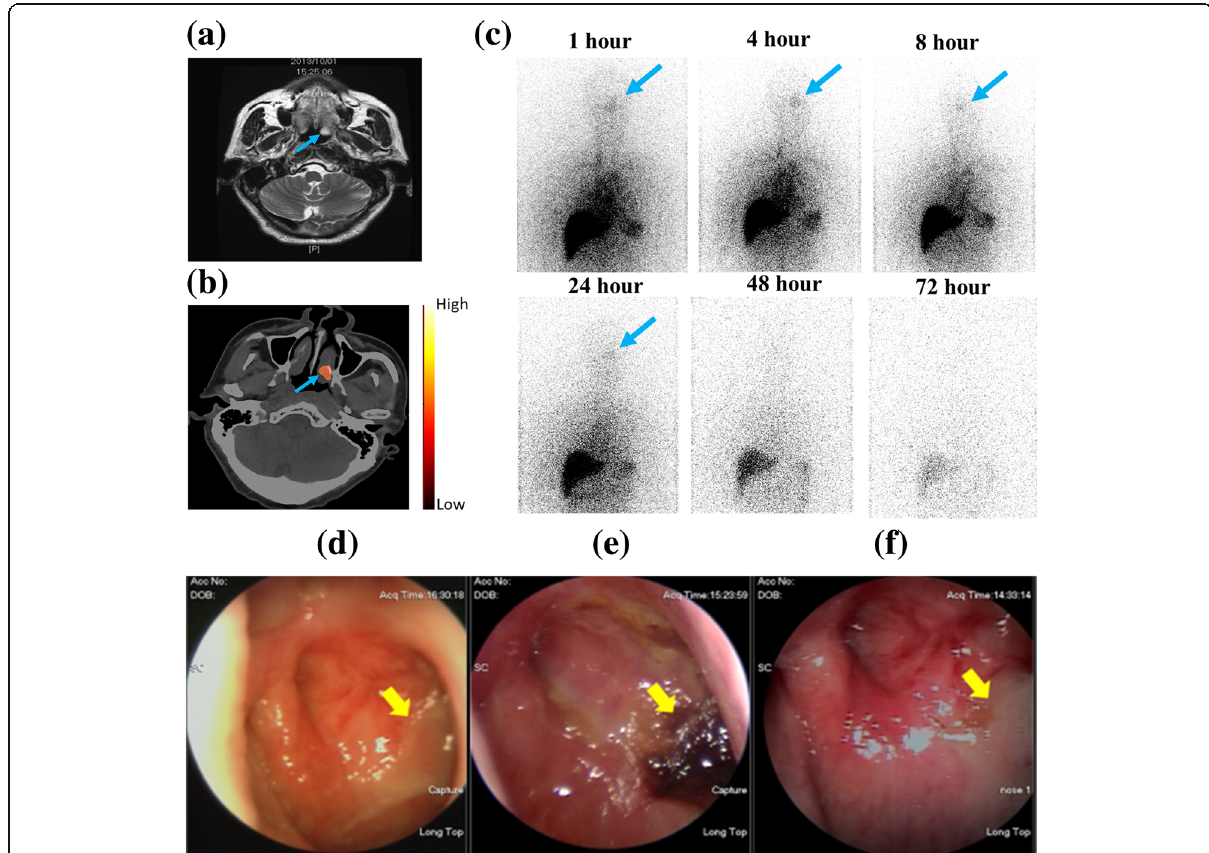
Fig. 3 188 Re-liposome SPECT/CT imaging showing tumor targeting and uptake in a NPC patient (Pt. 14) with pulmonary and mediastinal metastasis: a 1 month before 188 Re-liposome injection, MRI there is a soft tissue lesion (blue arrow) in the left nasopharynx; b SPECT/CT 24h after 188 Re-liposome injection, there is a high uptake and efficient targeting (3.99%ID/kg) in the corresponding tumor lesion (blue arrow), as seen on the MRI; c anterior upper-body images for patient 14 at six different time points after 188 Re-liposome injection (blue arrows indicate the lesion over the left nasopharynx); d the nasopharyncoscopic examination 1 month before 188 Re-liposome injection shows the left nasopharyngeal mass with a crust and mucoid (yellow arrow); e 2 months after 188 Re- liposome injection, there are engorged blood vessels and irregular surface over the left nasopharynx (yellow arrow); and f 1 year after the trial, the nasopharyngoscopic study shows fibrosis over the left nasopharynx (yellow arrow)